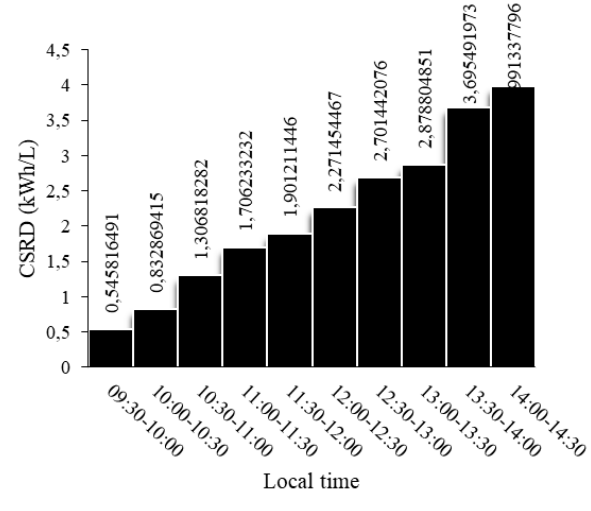
Figure 3: Estimated cumulative solar radiation dose (CSRD) in the period of experiments into the reactor per unit of time and volume.